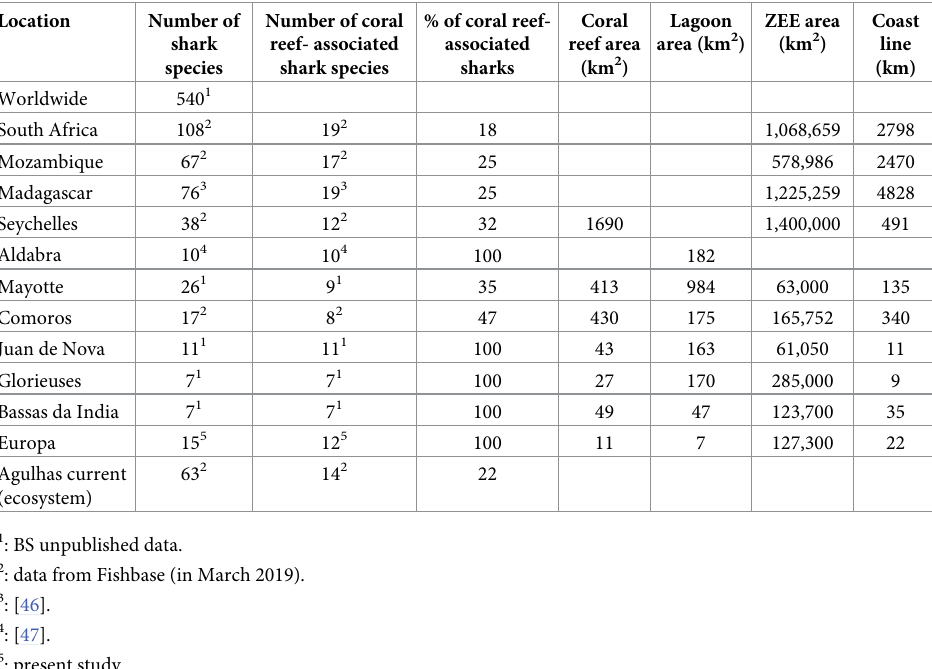
Table 3. Number of shark species in the Eparses Islands compared to neighboring areas, in relation to some geo- morphological